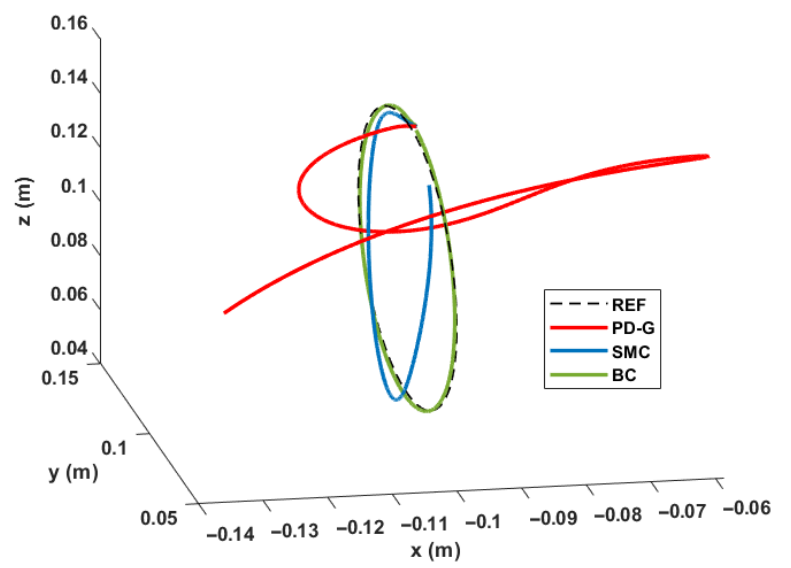
Figure 15. Comparison of controllers for the 3D movement of the end effector to w = 2.1